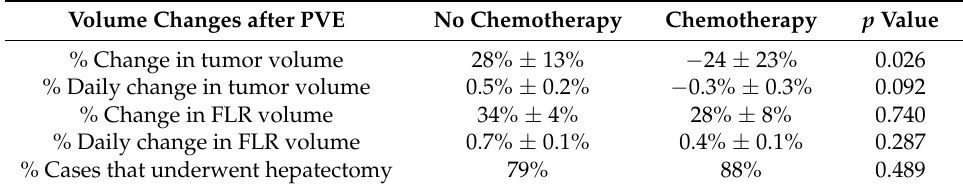
Table 3. Outcomes after